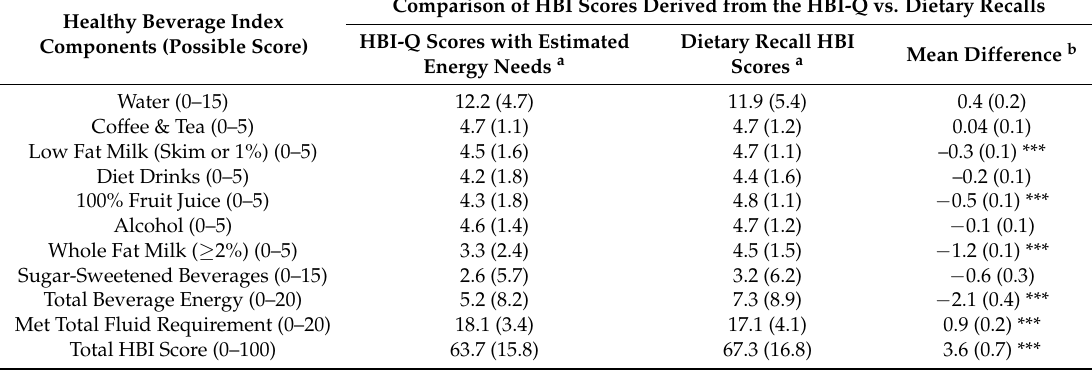
Table 4. Comparison of Healthy Beverage Index (HBI) scores from the HBI-Q and dietary recalls ( n = 404). Comparison of HBI Scores Derived from the HBI-Q vs. Dietary Recalls Healthy Beverage Index HBI-Q Scores with Estimated Components (Possible Score) Energy Needs